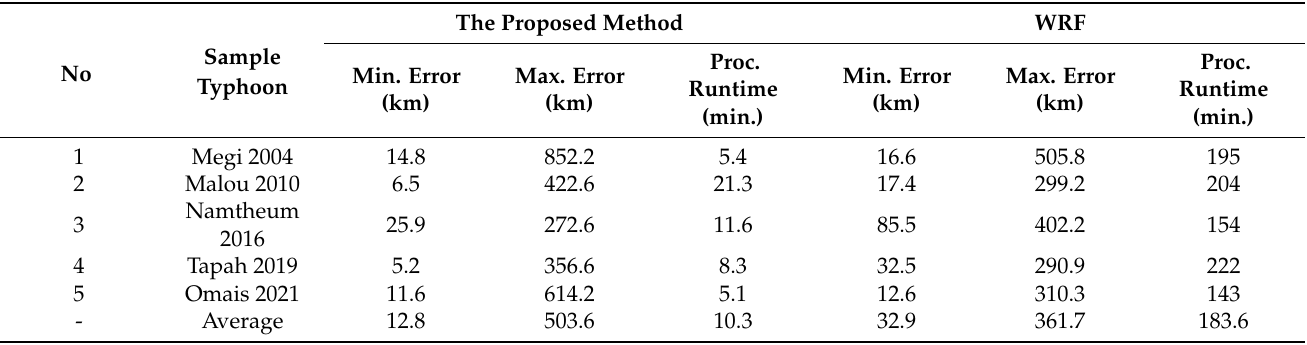
Table 3. The skill summary of the proposed method and its comparison with the WRF